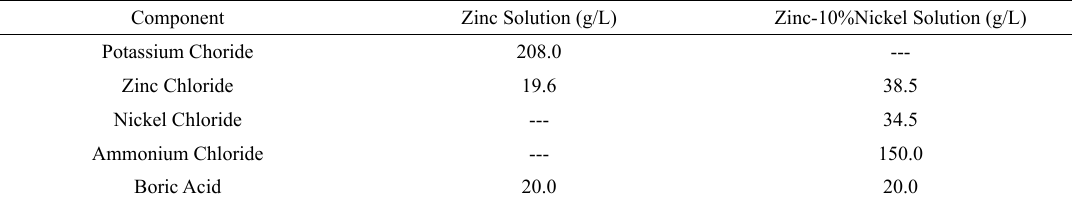
Table 2. Composition of the electrolyte solution used for zinc and zinc-nickel alloy electroplating.